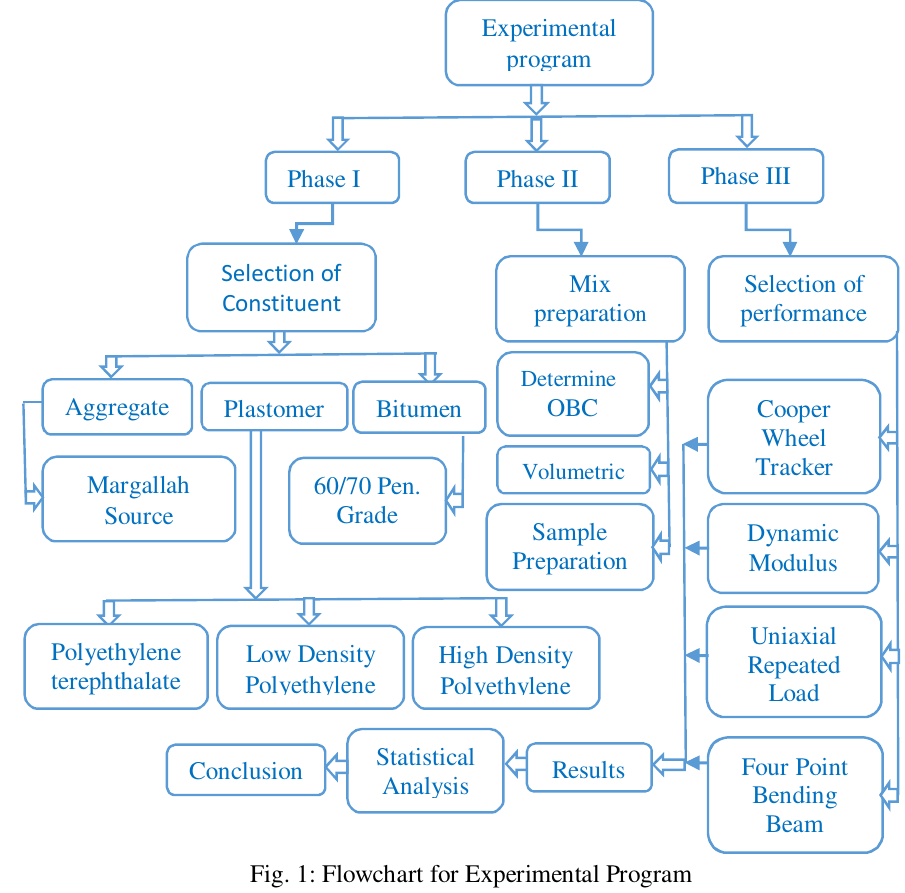
Fig. 1: Flowchart for Experimental